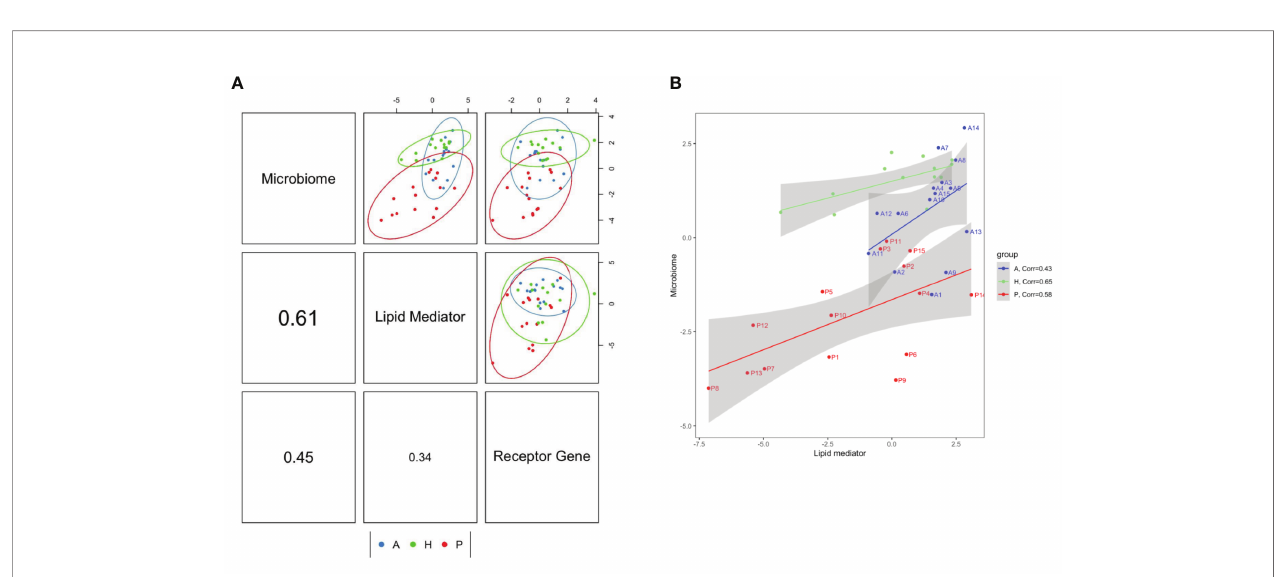
FIGURE 4 | Correlations between lipid mediator pro fi le, specialized pro-resolving lipid mediator (SPM) receptor gene pro fi le and subgingival microbiome pro fi le. (A) The component correlation plots represent subgingival microbiome-lipid mediator pro fi le (upper-middle box), subgingival microbiome-receptor gene pro fi le (upper-right box), and lipid mediator-receptor gene pro fi le (middle-right box). The correlation coef fi cient of these pro fi les: subgingival microbiome-lipid mediator (middle-left box)= 0.61; subgingival microbiome-receptor gene (lower-left box)= 0.45; lipid mediator-receptor gene (lower-middle box)= 0.34. (B) The correlation plot demonstrates the subgingival microbiome-lipid mediator correlation patterns in each subject group. The correlation coef fi cients for the H, P and A groups are 0.65, 0.58 and 0.43, respectively. Most of the subject ’ s subgingival microbiome-lipid mediator pro fi les (subjects are labeled in the plot) in periodontitis before treatment move toward the healthy patterns after treatment. (H (green): healthy; P (red): periodontitis before non-surgical therapy; A (blue): periodontitis after non-surgical therapy; one dot represents one subject in each group; numbers on axes represent relative levels of bacterial species, lipid mediators or receptor gene expression; the analyses are performed using the DIABLO